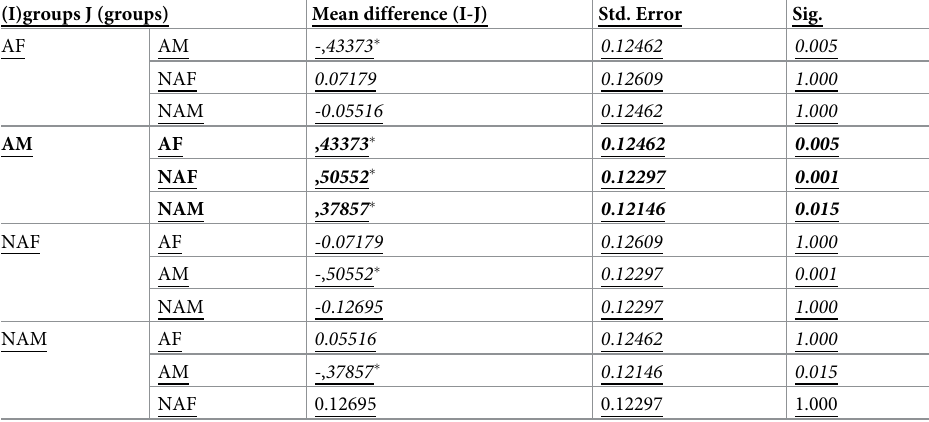
Table 1. Post hoc comparisons.